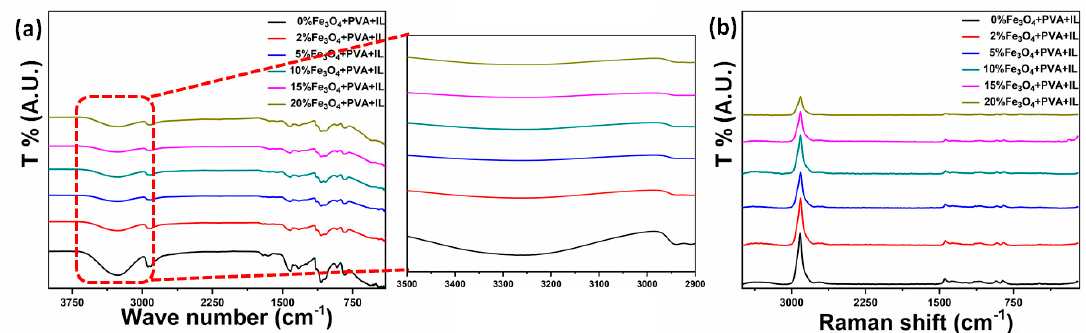
Figure 4. ( a ) Fourier-transform infrared (FTIR) and ( b ) Raman spectroscopy measurements of the PVA-glycerol-Fe 3 O 4 membranes at different wt% concentrations of nanoparticles. IL refers to glycerol in the legend.